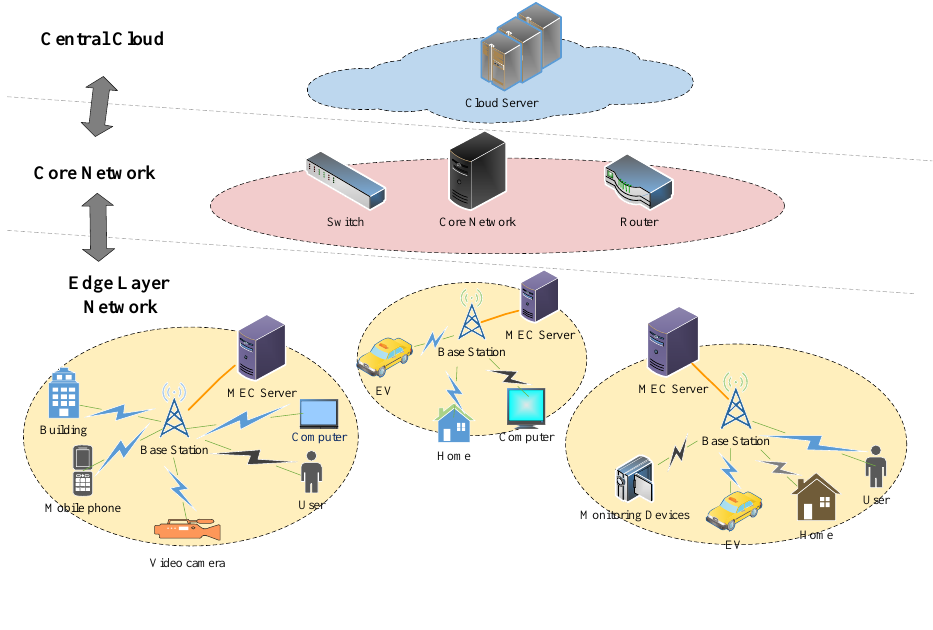
Figure 1. Applications of mobile edge computing in the smart